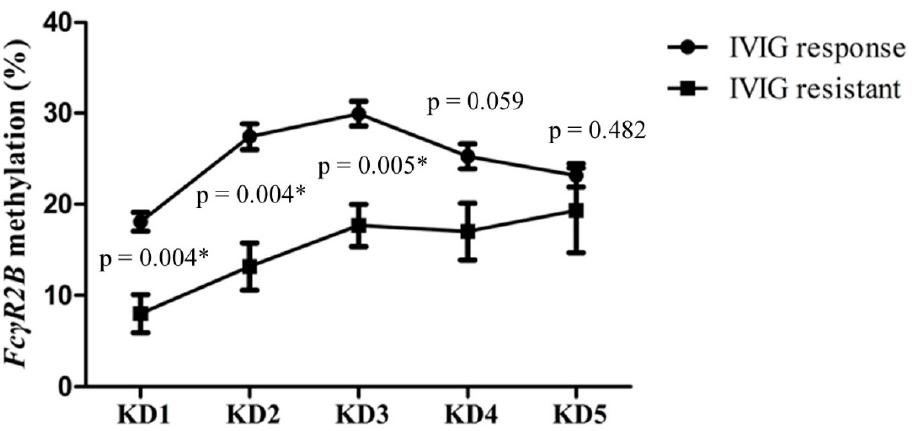
Figure 4. Fc γ R2B methylation was lower in the intravenous immunoglobulin (IVIG)-resistant group than in the IVIG-responsive group. KD, Kawasaki disease; KD1, within 24 h prior to IVIG treatment; KD2, 3–7 days after IVIG; KD3, three weeks after IVIG, KD4, six months after IVIG; KD5, one year after IVIG. * p <